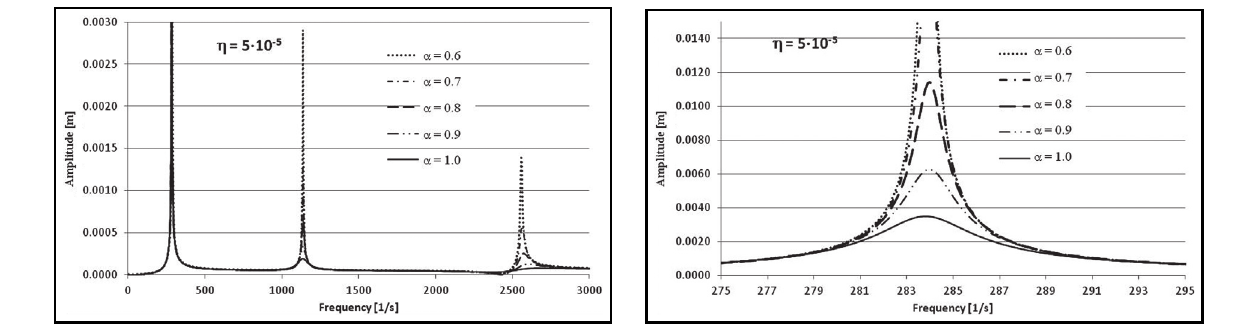
Fig. 6. Amplitude-frequency characteristic η = 5 · 10 − 5 . Fig. 7. Amplitude-frequency characteristic – 1-st